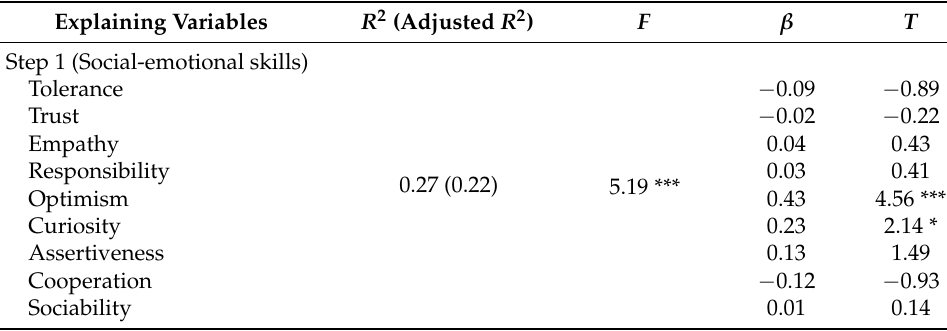
Table 3. Results from the hierarchical linear regression